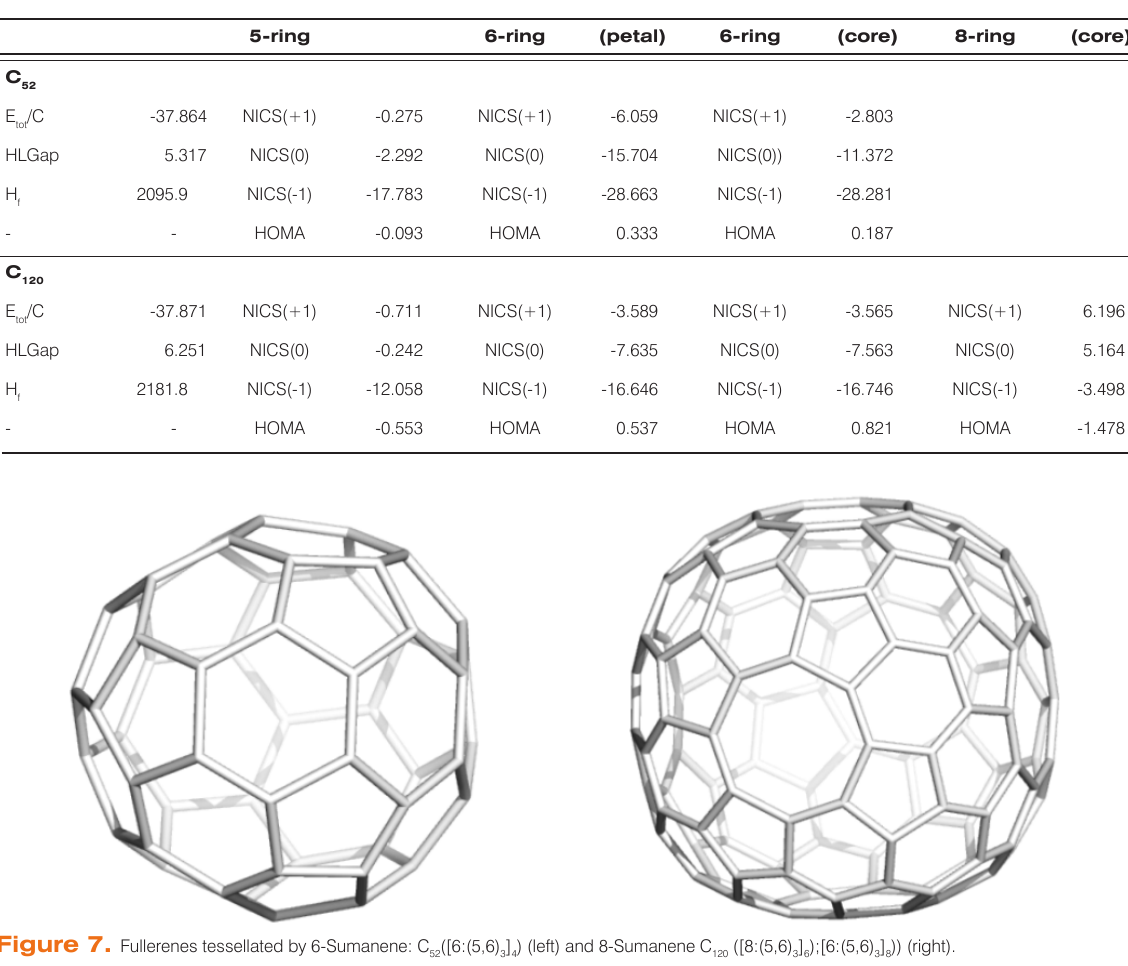
] ) (left) and 8-Sumanene C 3 4